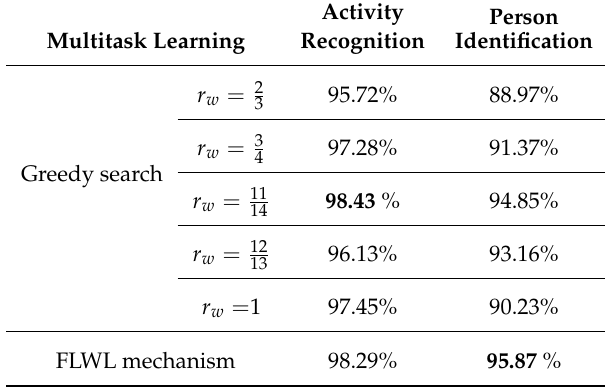
2.3 2.4 and . 2.7 2.6